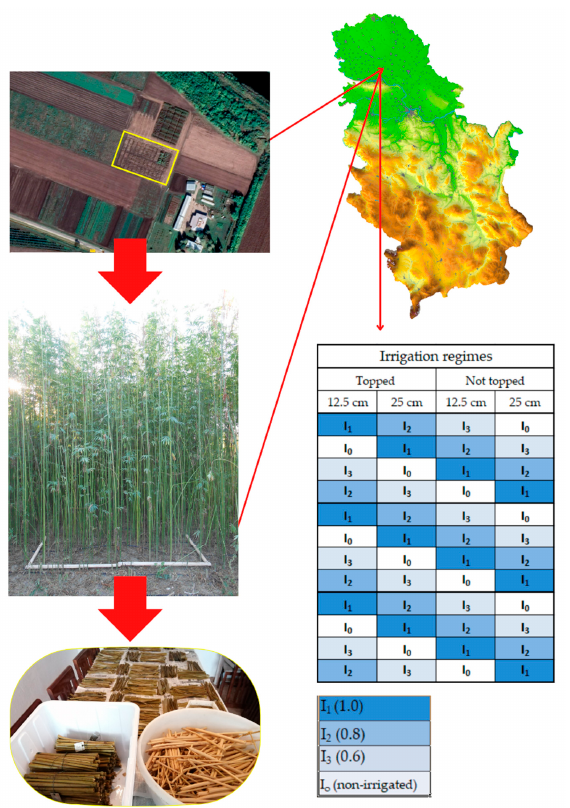
Figure 1. Location of the trial and experimental design showing the main analyzed factors: irrigation 1.00 (I 1 ), 0.80 (I 2 ), and 0.60 (I 3 ) corresponding, respectively, to daily evaporation from an open water surface (E o ), I o (non-irrigated control variant), two interrow spacings: RS 1 (12.5 cm) and RS 2 (25 cm), and topped (T) and not topped (NT) variants.